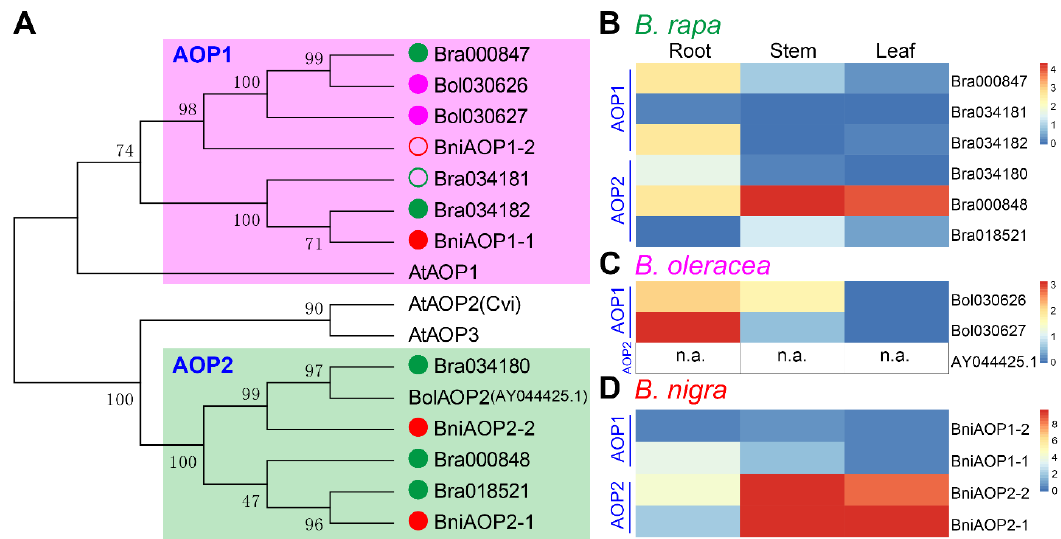
Figure 8. The phylogenetic tree and heatmap of AOP genes in Brassica rapa , Brassica oleracea , Brassica nigra , and Arabidopsis thaliana . ( A ) The phylogenetic tree of AOP genes. The AOP genes identified from Brassica rapa , Brassica oleracea , and Brassica nigra are indicated by green, purple, and red hollow circles or solid discs. The silenced genes are represented by a hollow circle, expressed functional genes are indicated by a solid disc. The heatmap of AOP genes in Brassica rapa ( B ), Brassica oleracea ( C ), and Brassica nigra ( D ). n.a., not available. The expression data of B. rapa and B. oleracea were obtained from ref [48,49].